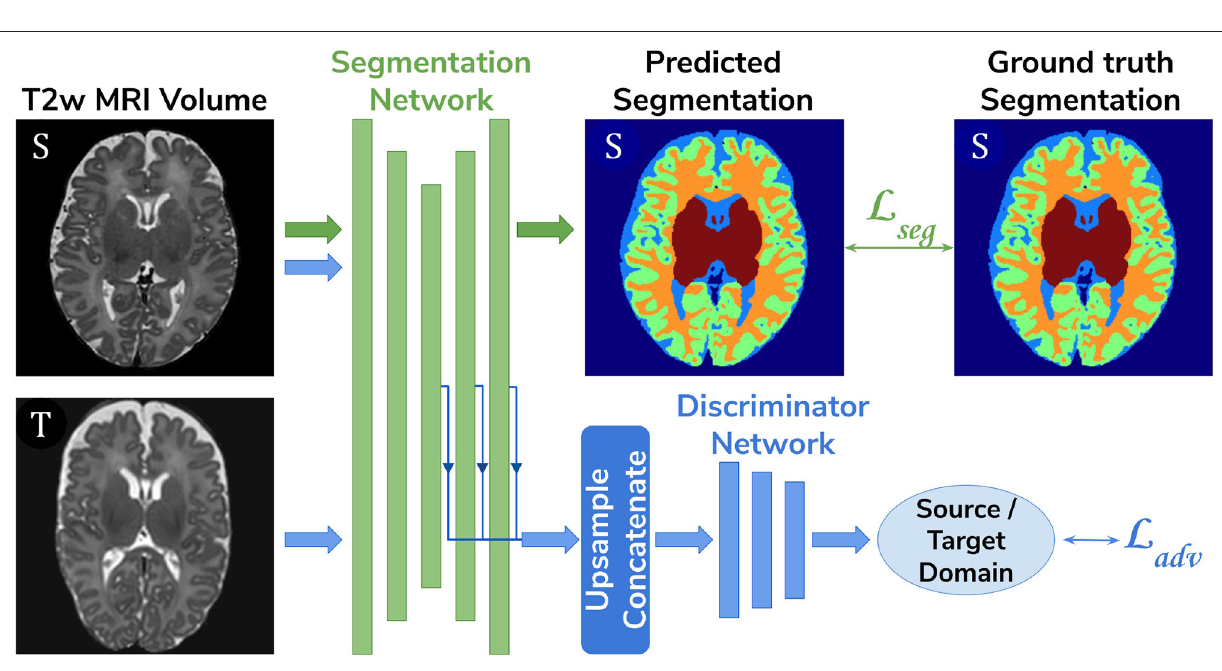
FIGURE 3 | The latent space domain adaptation setup consists of a 3D U-Net trained to segment the source (dHCP) T 2 w MRI volumes, coupled with a discriminator network which forces the segmentation network to learn domain-invariant features. Both source (dHCP) and target (ePrime) images are fed to the segmentation network, but only source (dHCP) Draw-EM output labels are used to compute the segmentation loss. Source domain images are marked with S, while target domain images are marked with T,